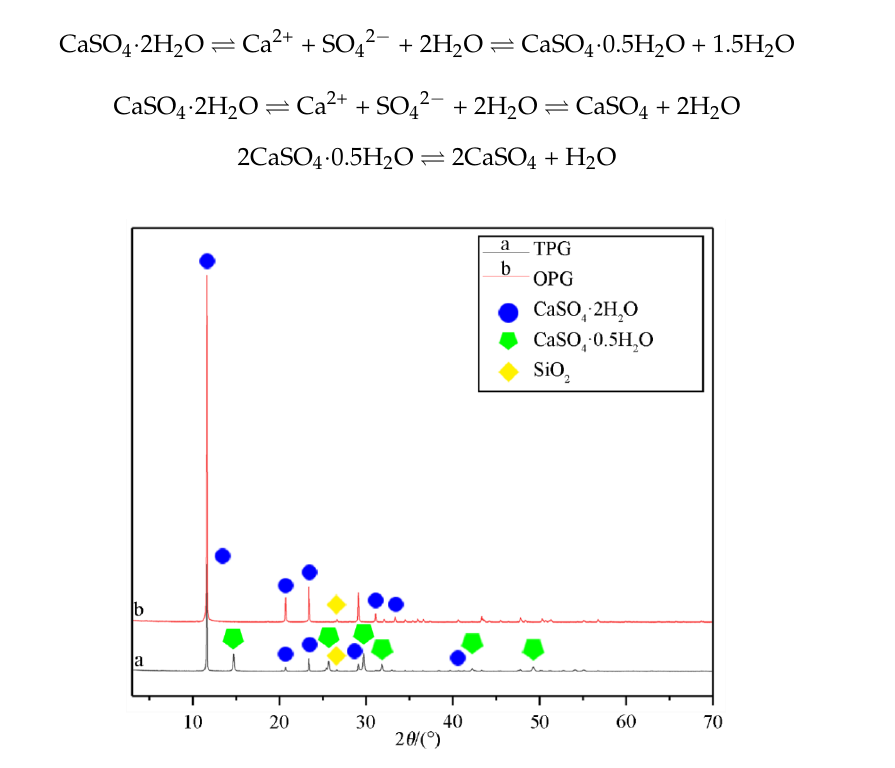
Figure 8. Workability of the mixtures with OPG and TPG. ( a ) Values of slump; ( b ) values of fluidity.